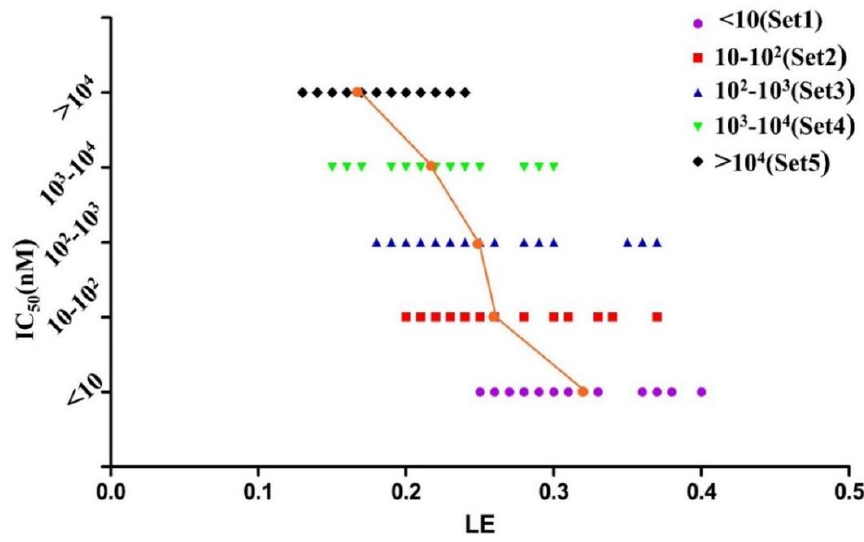
Figure 5. The graph of potency (IC 50 ) vs LE of 156 MDM2/p53 PPIIs.